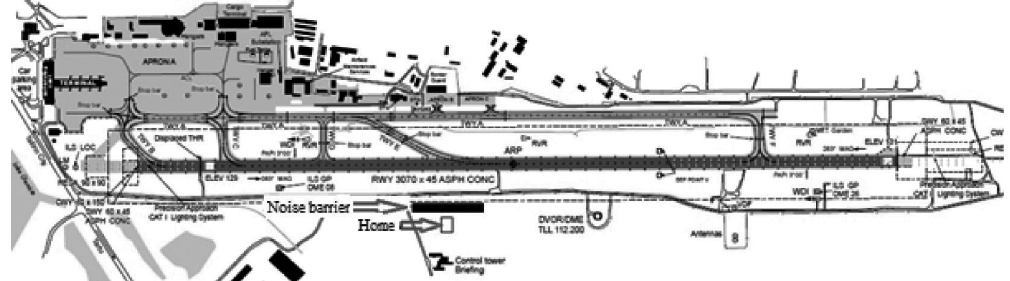
Fig. 4. The recommended location for the noise barrier (Mäsak